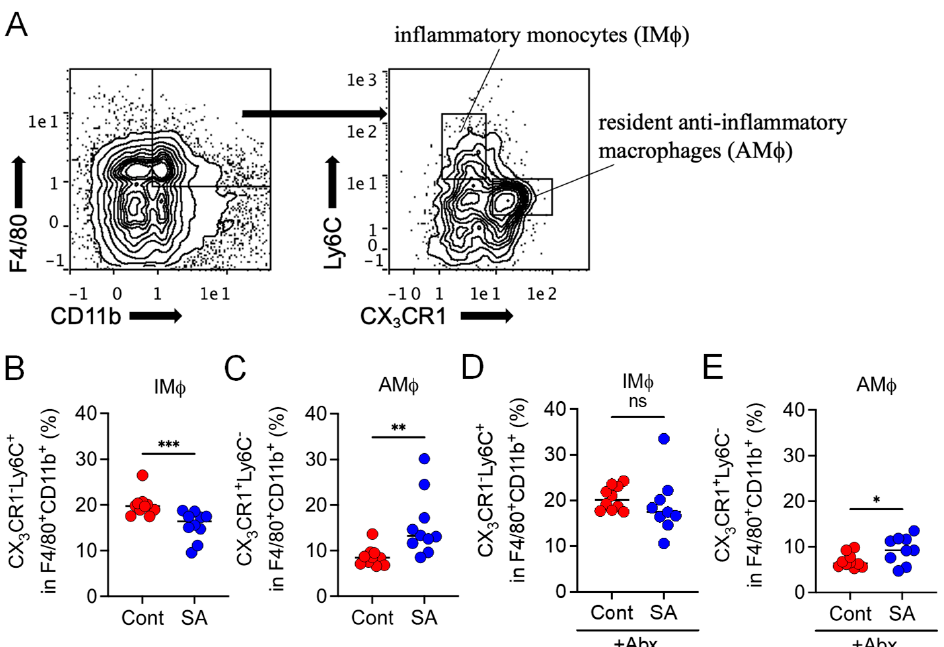
Figure 4. Dietary treatment with sodium alginate (SA) reduced the abundance of inflammatory monocytes in the colon by altering the gut microbiota composition. Mice were fed a HFD supplemented with or without 5% SA for 4 weeks in the absence ( B , C ) or presence ( D , E ) of antibiotic (Abx) treatment ( n = 9 or 10 mice per group). The expression levels of CX 3 CR1 and Ly6C in CD11b + F4/80 + cells in the colon were analyzed via flow cytometry. ( A ) Representative flow cytometry images and frequencies of ( B , D ) CD11b + F4/80 + CX 3 CR1 low Ly6C + (inflammatory monocytes, IM φ ) and ( C , E ) CD11b + F4/80 + CX 3 CR1 high Ly6C − cells (resident anti-inflammatory macrophages, AM φ ). Each dot represents an individual mouse, and the horizontal bars indicate mean values. Statistical significance was assessed by Mann–Whitney U-test in ( B – D ), and unpaired Student’s t -test in ( E ). * p < 0.05; ** p < 0.01; *** p < 0.001; n.s., not significant. Cont: HFD diet; SA: HFD diet with 5% sodium alginate; Abx: erythromycin